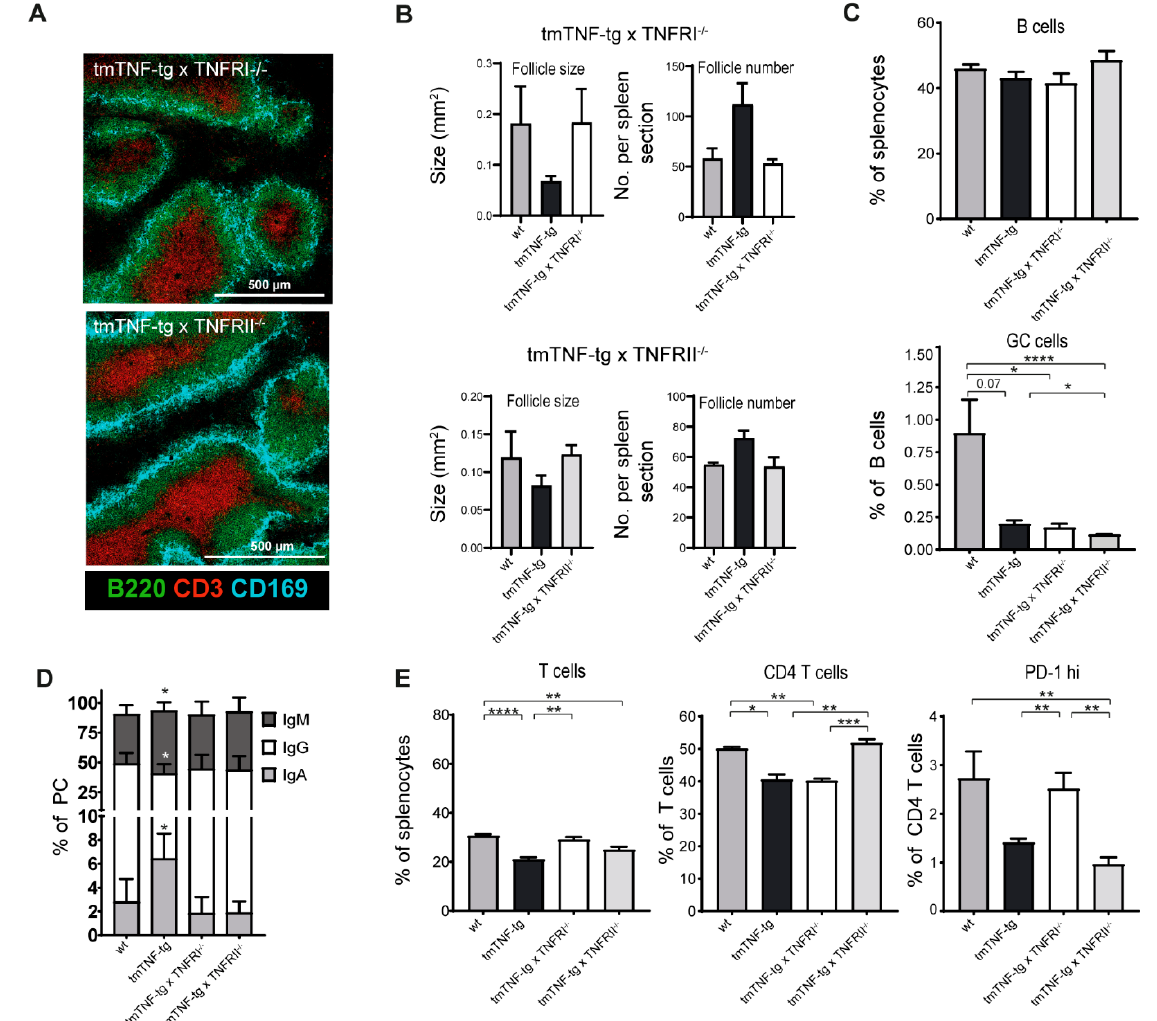
Figure 6. Effects of TNFRI and TNFRII deficiency on tmTNF-induced effects in lymphoid follicles of the spleen. Different spleen populations were analyzed via flow cytometry and immunofluorescent staining. ( A ) Representative images of spleens obtained from tmTNF-tg × TNFRI − / − and tmTNF-tg × TNFRII − / − mice. Splenic lymphoid follicles contained B and T cell areas with defined CD169 + marginal zones (CD3 = marker for T cells; B220 = marker for B cells). ( B ) Restoration of follicle size and number in the spleen of tmTNF-tg × TNFRI − / − mice (left panels) and tmTNF-tg × TNFRII − / − (right panels) to levels comparable to wt mice ( n = 2–3). ( C ) Analysis of B cell and GC B cell numbers. Total B cell proportions were not changed in the spleen of tmTNF-tg × TNFRI − / − and tmTNF-tg × TNFRII − / − mice. GC B cell proportions were comparable in the spleen of tmTNF-tg and tmTNF-tg × TNFRI − / − mice and further decreased in spleen of tmTNF-tg × TNFRI − / − mice compared to the spleen of tmTNF-tg mice. TNFRI or –II knock-out in tmTNF mice did not affect GC LZ and DZ ratios ( n = 6). ( D ) Analysis of PC Ig-classes in spleen samples. IgA + and PC populations were decreased in tmTNF-tg × TNFRI − / − and tmTNF-tg × TNFRII − / − mice compared to tmTNF-tg mice and restored to levels comparable to wt mice. Test for significance for wt mice in comparison to the individual transgenic mouse lines ( n = 6). ( E ) Analysis of GC-associated T cells. The T cell fraction increased in tmTNF-tg × TNFRI − / − mice compared to tmTNF-tg mice and restored to levels comparable to wt mice. The CD4 + T cell proportion increased in tmTNF-tg × TNFRII − / − mice compared to tmTNF-tg mice and restored to levels comparable to wt mice. PD-1 hi T cells were increased in tmTNF-tg × TNFRI − / − mice compared to tmTNF-tg mice and restored to levels comparable to wt mice and further decreased in tmTNF-tg × TNFRII − / − mice ( n = 6). GC = germinal center; LZ = light zone; DZ = dark zone; PC = plasma cell; Ig = immunoglobulin; * = p ≤ 0.05; ** = p ≤ 0.01; *** = p ≤ 0.001; **** = p ≤ 0.0001).